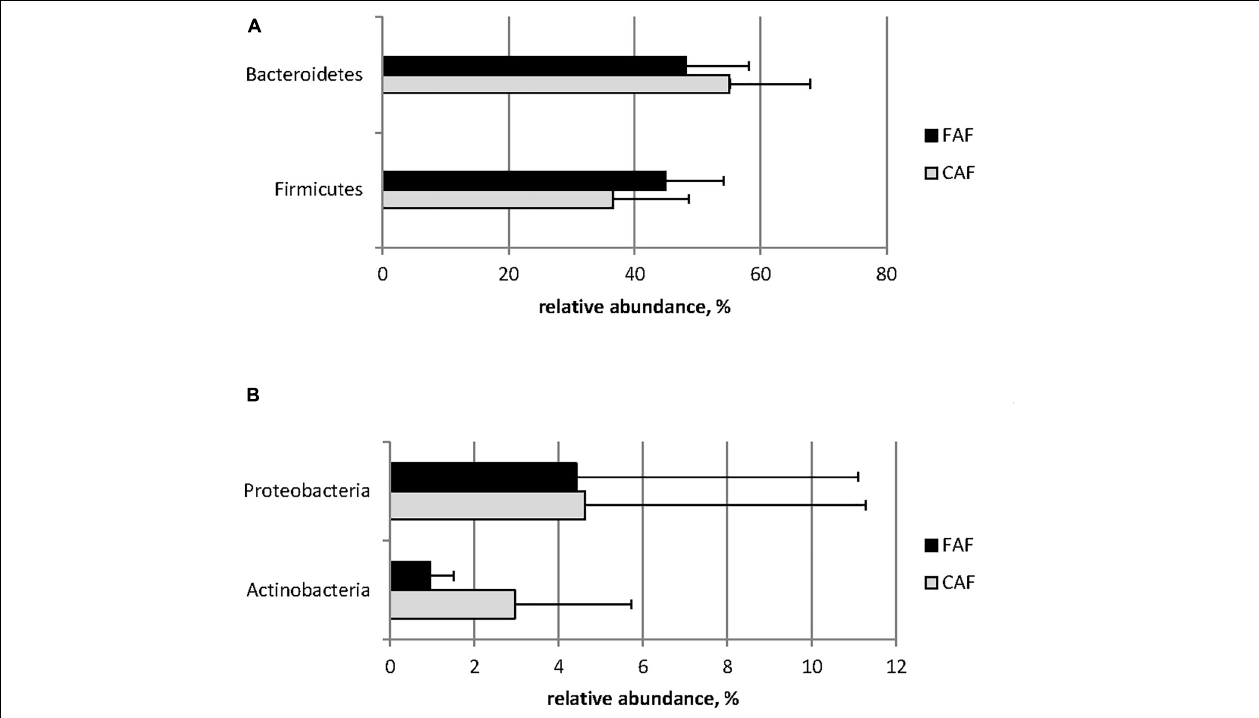
FIGURE 2 | Means of major (A) and minor (B) phylum (relative abundance > 1%) significantly ( Q < 0.001) affected by the diet/period test: 78 lambs received during a first period a 100% concentrates diet (CAF, ) and then in a second period 62 of them were kept to a 67% hay diet (FAF, ).